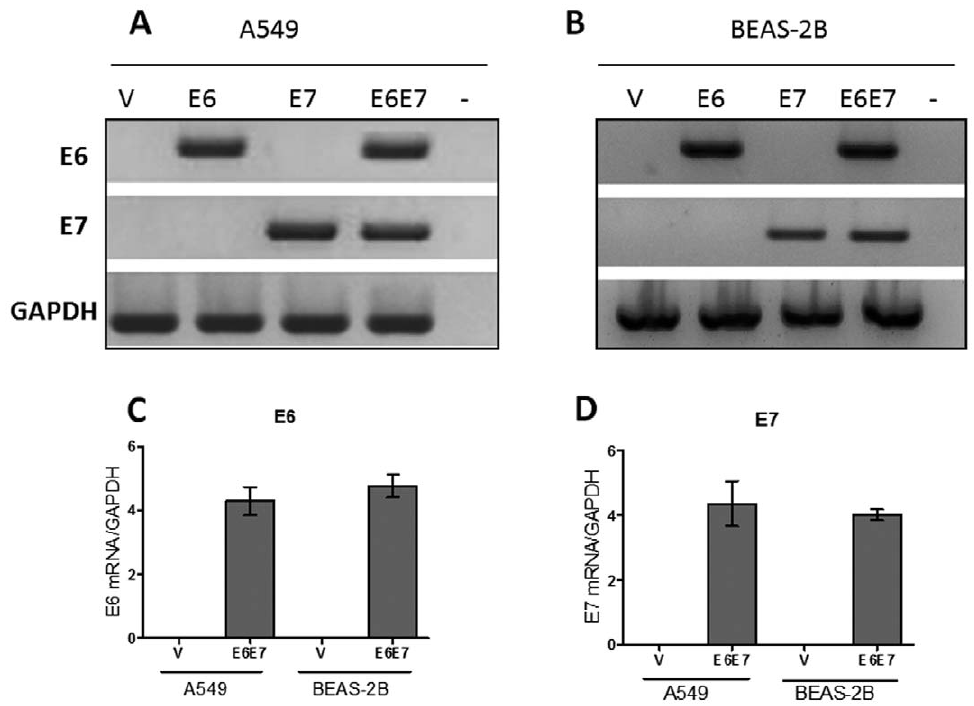
and BEAS-2B cells transfected with pLXSNE6E7 constructs (mean 6 SD).